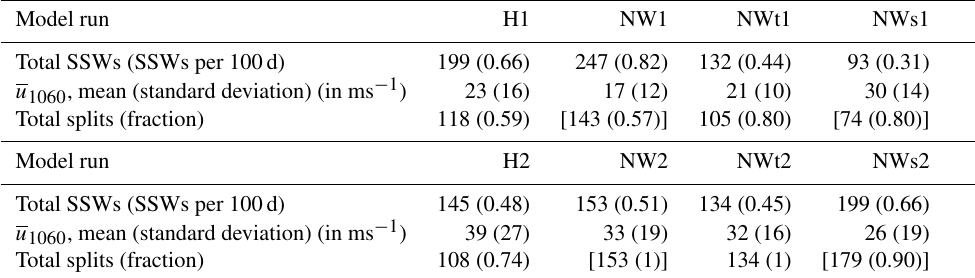
Table 1. SSW frequencies, time mean and variability in u at 10hPa and 60 ◦ N, and classifications for the model runs. Split and displacement numbers are obtained with a wave amplitude classification; numbers in square brackets indicate that the SSWs do not look like typical splits or